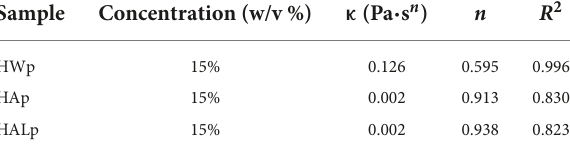
TABLE 3 Parameters of flow curves obtained by fitting to power law model.